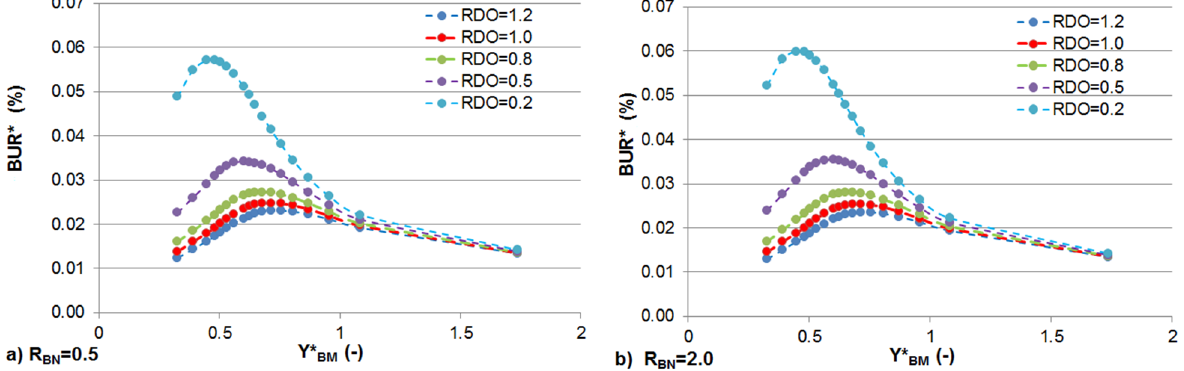
Figure 6. Dimensionless stream BUR , BUR * , as a function of the dimensionless mean flow depth, Y * BM , and R DO for ( a ) R BN = 0.5 and ( b ) R BN = 2.0, with R DO the ratio between in-stream DO ( DO 0 ) and total oxygen demand ( L 0C + L 0N ) and R BN the ratio between in-stream carbonaceous and nitrogenous BOD concentrations, R BN = L 0C /L 0N